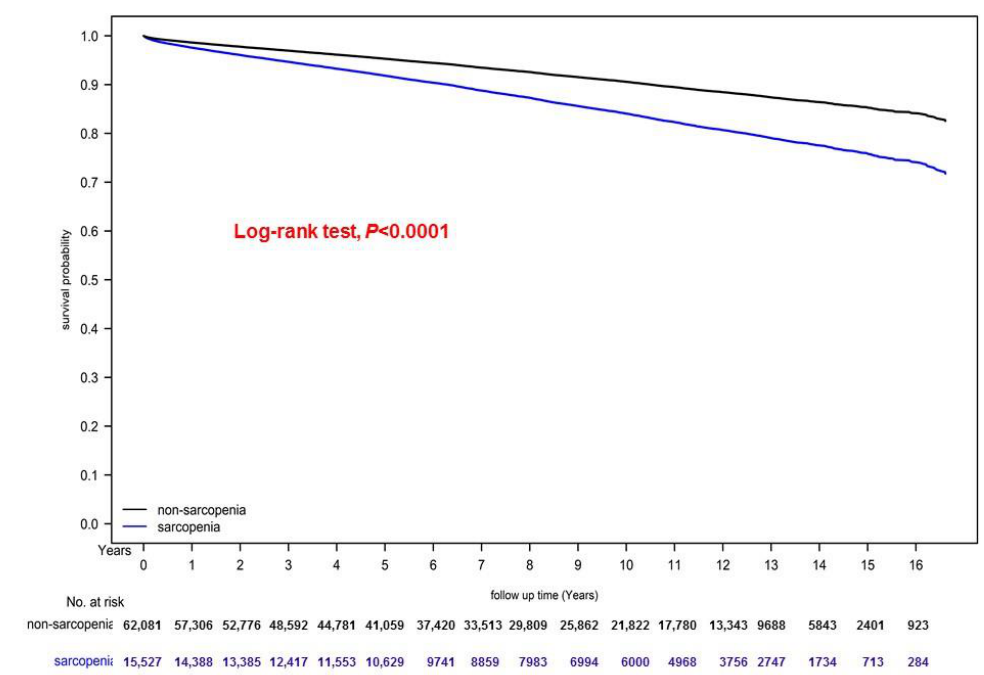
Figure 2. Kaplan–Meier curves for overall survival of patients with and without sarcopenia.